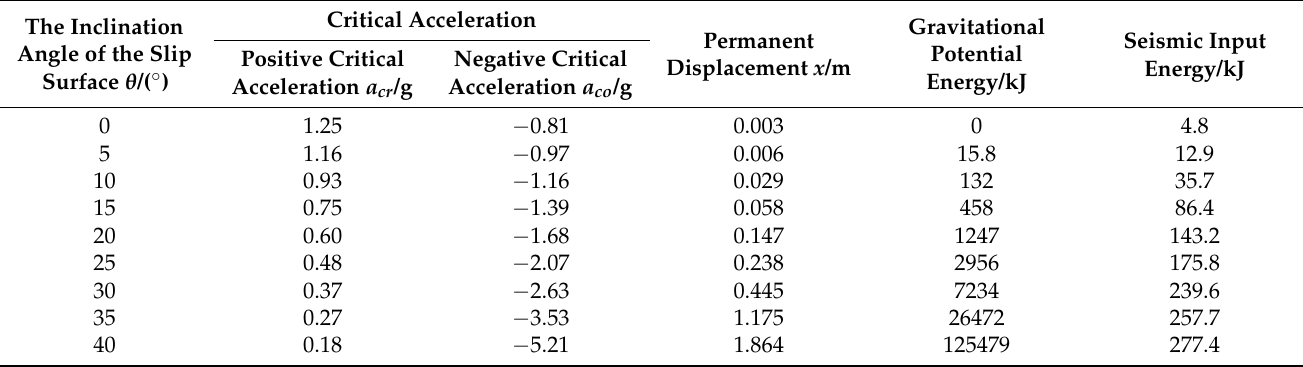
Table 5. Critical acceleration, permanent displacement and gravitational potential energy drop of sliding